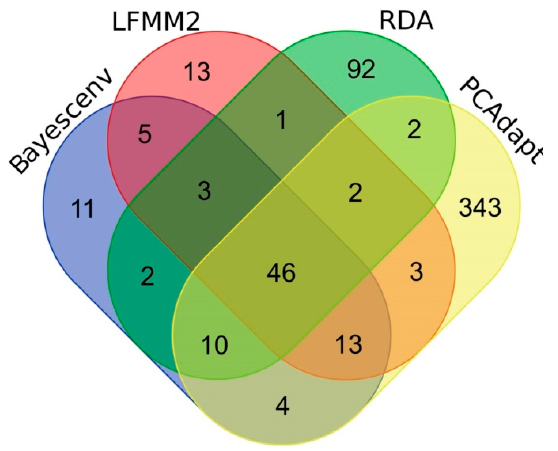
Figure 6. Venn diagram summarizing the results of the search for significant outlier SNPs using the four methods, LFMM, BayeScEnv, RDA and PCAdapt.